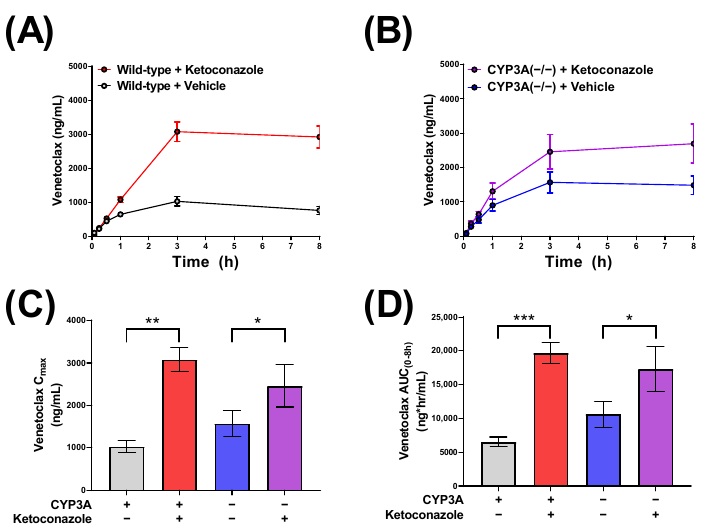
Figure 1. The ketoconazole-induced increases in venetoclax exposure are partially mediated by CYP3A. Plasma concentration curves of venetoclax in ( A ) female FVB wild-type or ( B ) CYP3A( − / − ) mice administered venetoclax (10 mg/kg; PO) 30 min after ketoconazole (50 mg/kg; PO) or vehicle (PEG400; PO) ( n = 5/group). Serial plasma samples were collected from each mouse and analyzed via LC-MS/MS. ( C ) Maximum concentration (C max ) and ( D ) area under the concentration-time curve (AUC) using the last observed timepoint (AUC 0–8h ) calculated with non-compartmental analysis (NCA) using Phoenix WinNonlin 8.1; * p < 0.05, ** p < 0.01, *** p < 0.001. In a separate experiment, CYP3A( − / − ) mice showed significantly greater venetoclax exposure when compared against wild- type FVB mice (Supplementary Figure S2; p = 0.01).